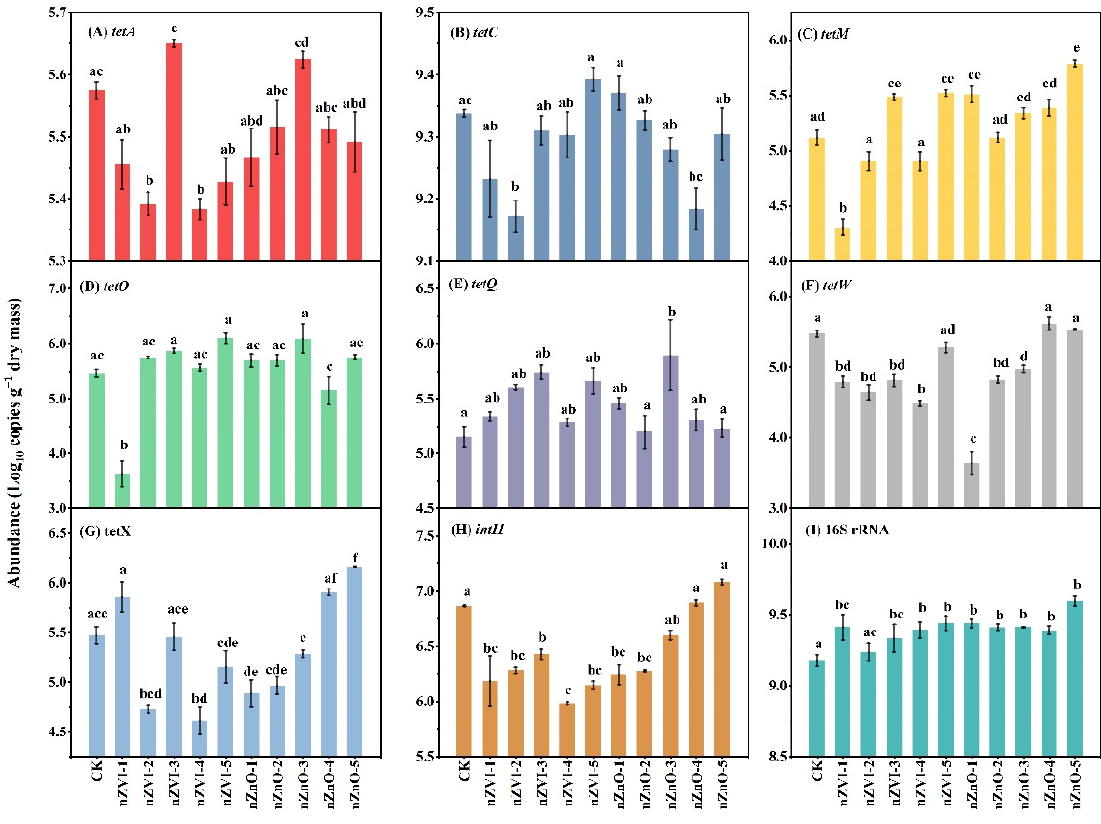
Figure 2. Effect of nanoparticles on the abundance of ( A ) tetA , ( B ) tetC , ( C ) tetM , ( D ) tetO , ( E ) tetQ , ( F ) tetW , ( G ) tet X, ( H ) intI1 and ( I ) 16S rRNA sediment overlaid with 10 mg L − 1 tetracycline solution (scenario 2). Different letters indicate p < 0.05.